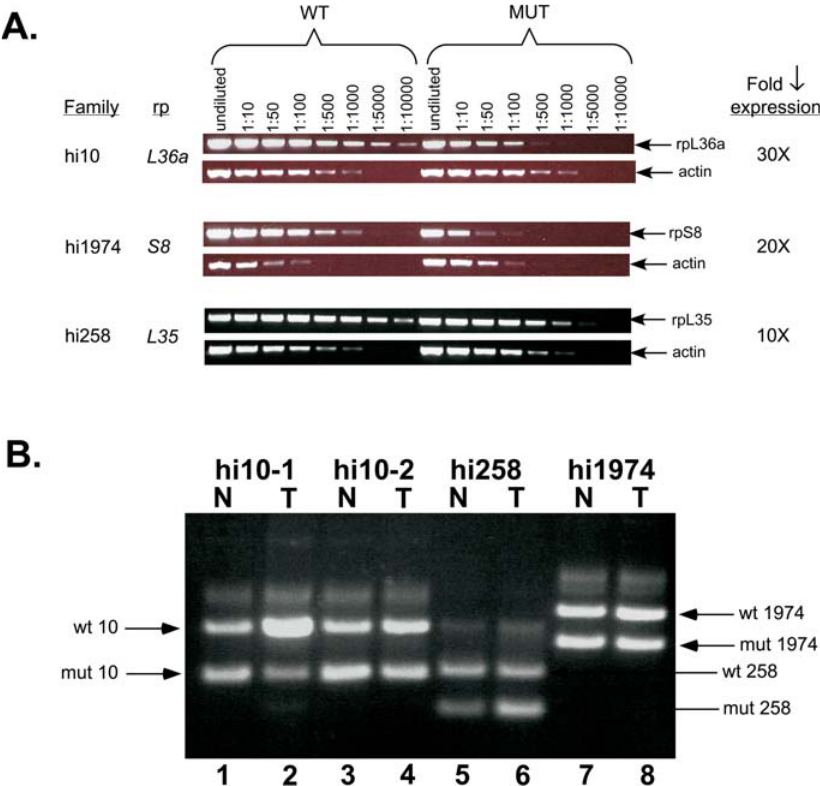
tumor samples shown in Figure 4, tumor hi10–1, the wild-type allele appears not only to be present but possibly at higher